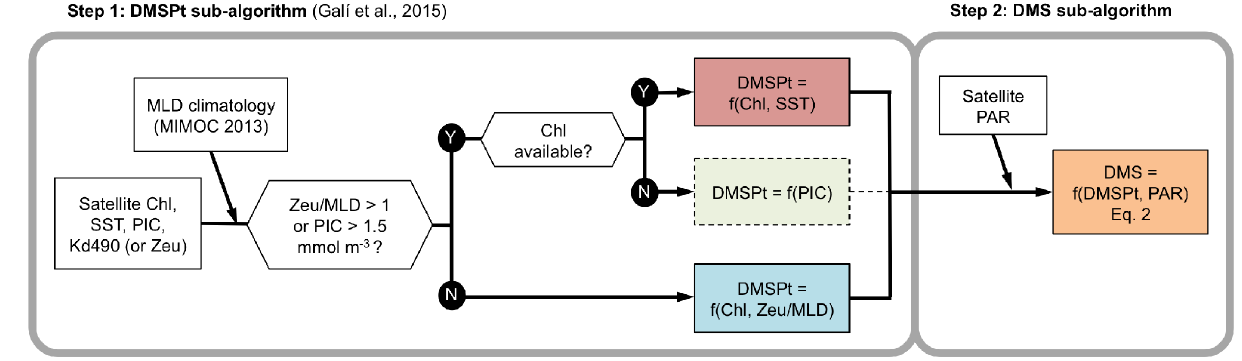
Figure 2. Scheme of the DMS SAT algorithm. The algorithm proceeds in two steps: the DMSPt sub-algorithm (described by Galí et al., 2015 see Appendix A) and the DMS sub-algorithm (this study). Dashed lines mark the PIC-based equation of the DMSPt sub-algorithm, which in practice is not used when gap-free satellite Chl fields are used as